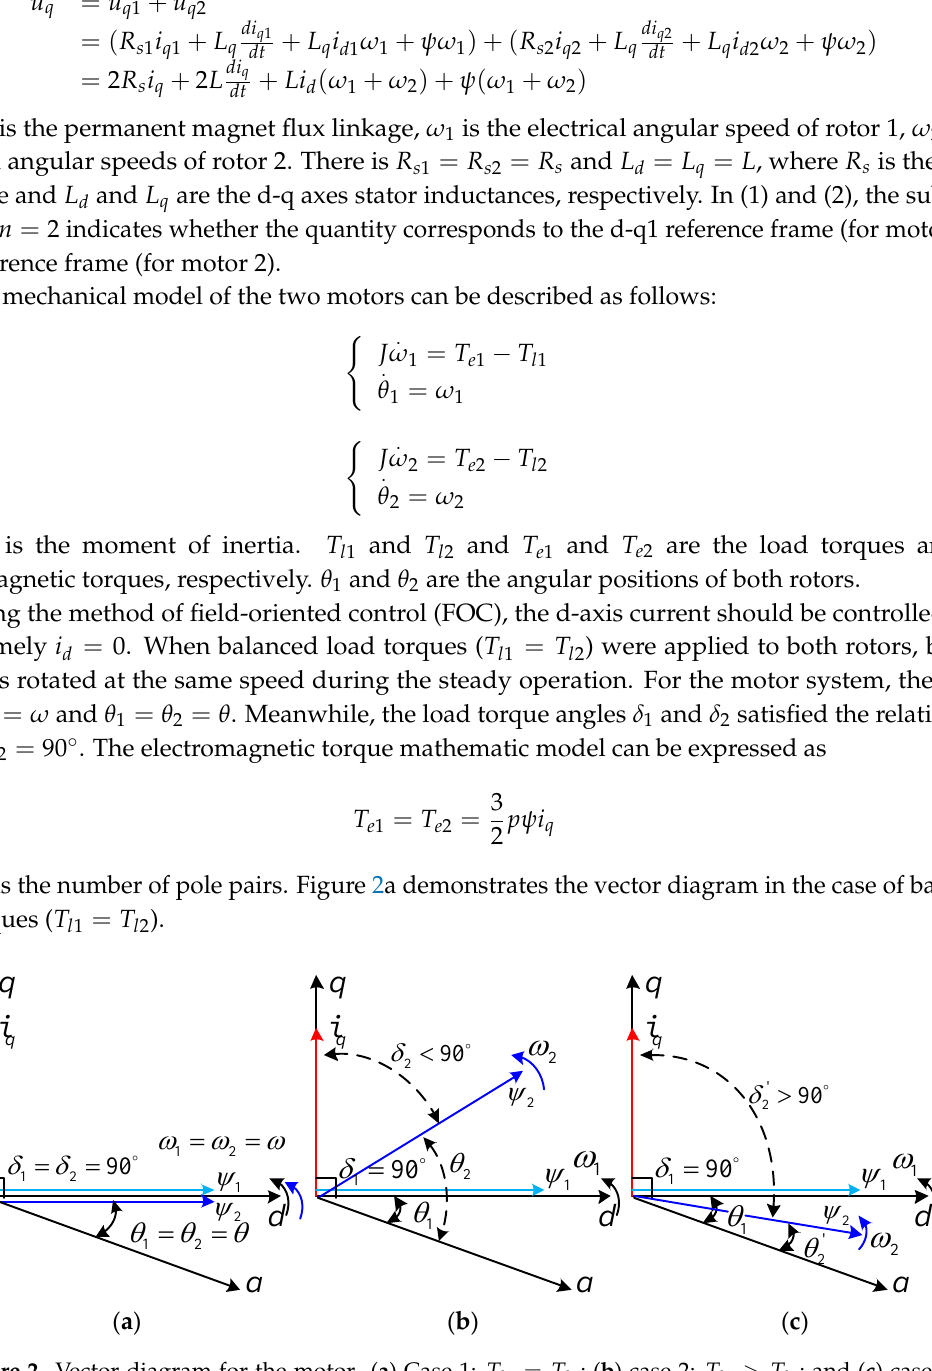
Figure 2. Vector diagram for the motor. ( a ) Case 1: T l 1 = T l 2 ; ( b ) case 2: T l 1 > T l 2 ; and ( c ) case 3: T l 1 < T l 2